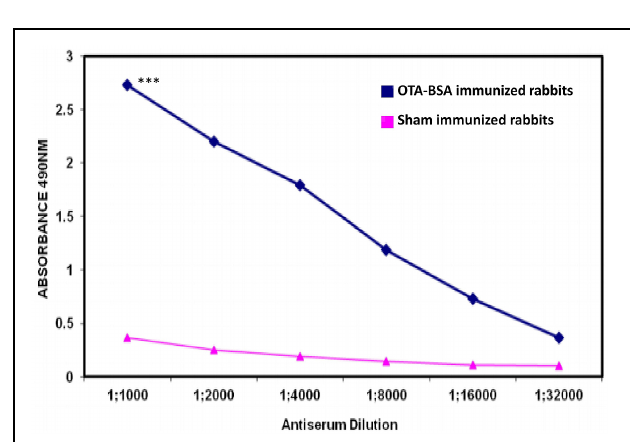
FIGURE 2 | Antibody titres induced by immunization of OTA-BSA conjugate to New Zealand White rabbits. ∗∗∗ P ≤